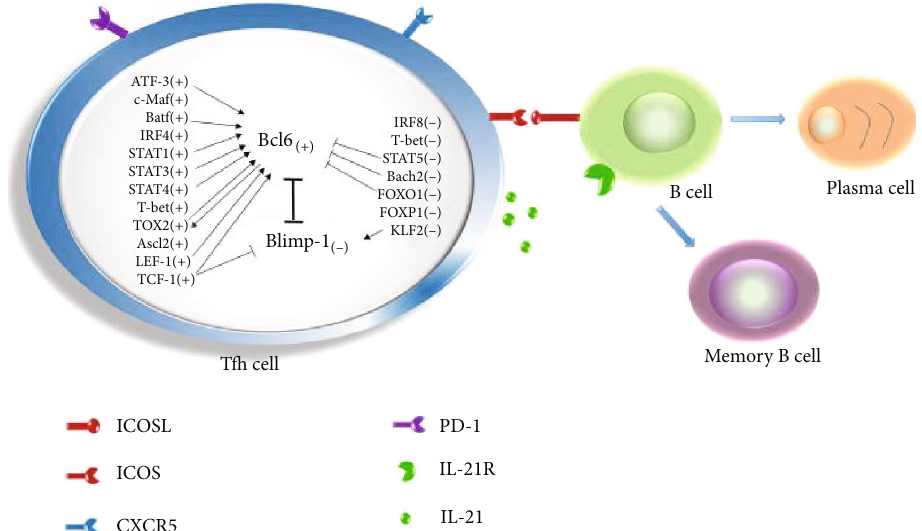
Figure 2: Network of transcription factors in the di ff erentiation of Tfh cells. Tfh cells are regulated by a complex network of transcription factors, including Bcl6, Blimp-1, ATF-3, c-Maf, Batf, IRF4, IRF8, STATs, T-bet, TOX2, Ascl2, LEF-1, TCF-1, Bach2, FOXO1, FOXP1, and KLF2. “ + ” means positive factors and “ − ” means negative factors. “ → ” means the promoting e ff ect and “ ⊣ ” means the inhibitory e ff